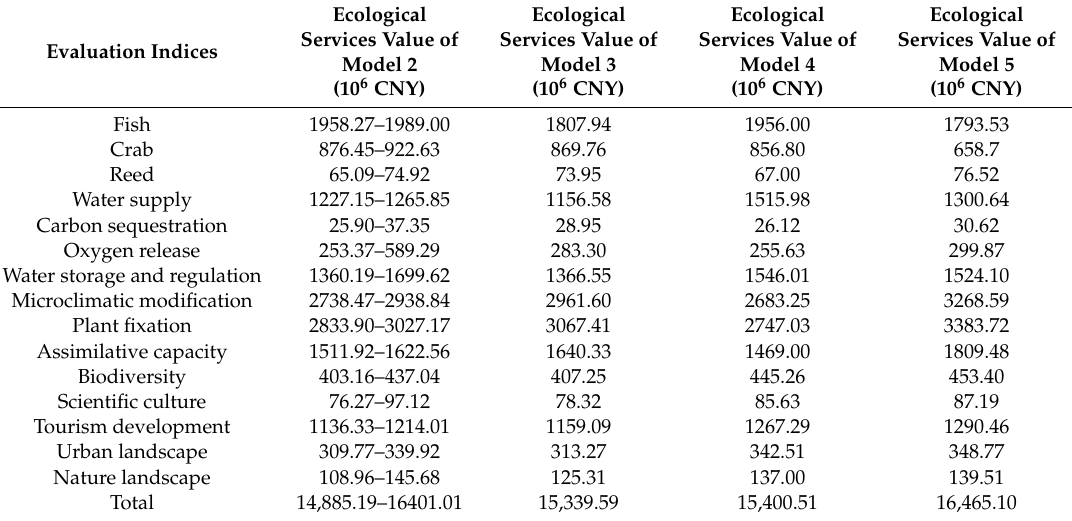
Table 5. Comparison of the ecological service value optimized by di ff erent